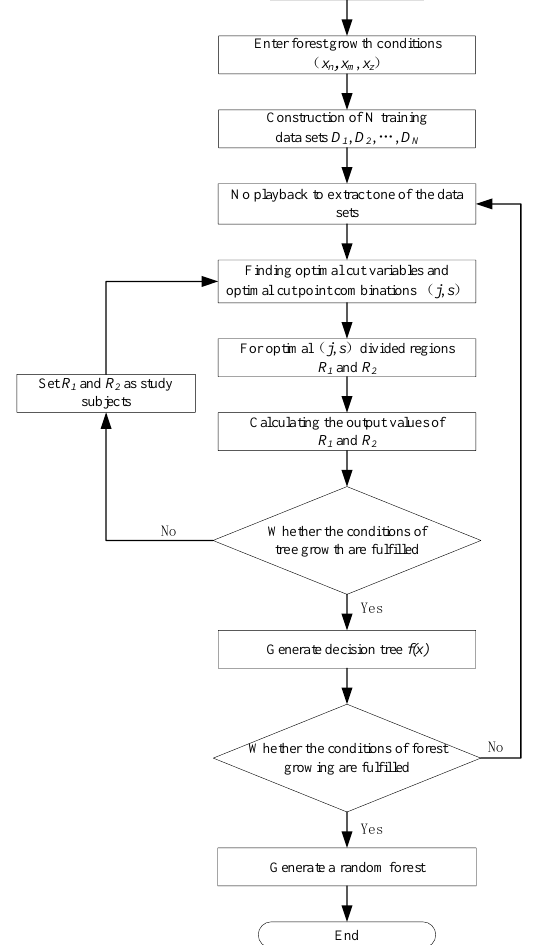
Figure 2. RF algorithm flow chart.